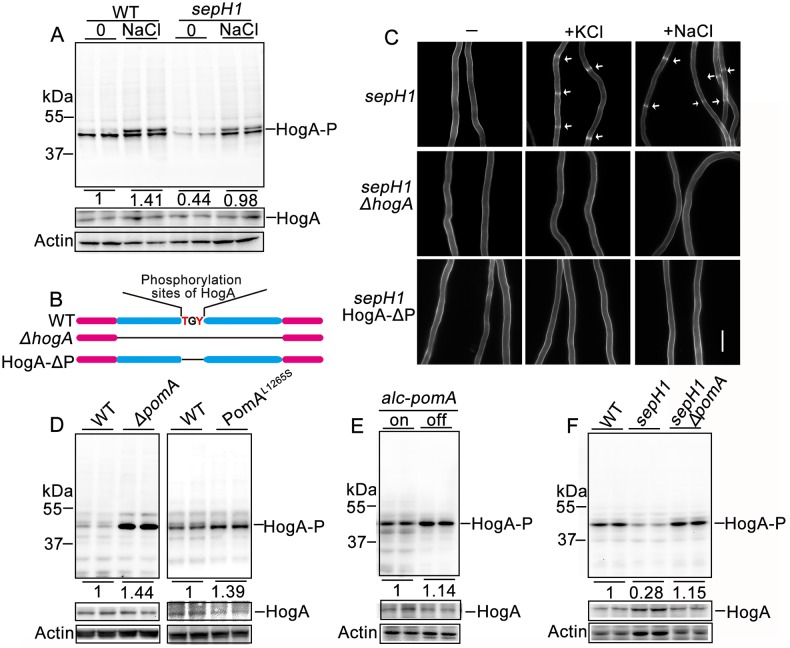
PomA and SepH reversely affected the phosphorylation of HogA.(A) The phosphorylation level of wild type (TN02A7) and sepH1 strains cultured in liquid minimal media PGRUU treated with or without 1 M NaCl for 10 min at 42 °C for 24 h. (B) Diagram showing strategies of HogA full-length deletion and deleted for predicted phosphorylation sites (171–173) of HogA. (C) Comparison of hyphal cells stained with CFW for the sepH1, sepH1 ΔhogA and sepH1 HogA-ΔP with or without treatment of 1 M NaCl or 1 M KCl at 42 °C. Arrows indicate the locations of septa. Bars, 10 μm. (D) Western blot analysis showing the expression level of P-HogA in the pomA null mutant and the pomA site-directed strain cultured in liquid minimal media PGRUU at 37 °C or (F) sepH1 relative strains at 42 °C for 24 h. (E) Western blot analysis showing the expression level of P-HogA in the alc(p)::GFP-pomA strain cultured in de-repressed media MMPGR at 37 °C for 24 h or transferred to repressed media YAG for 30 min.